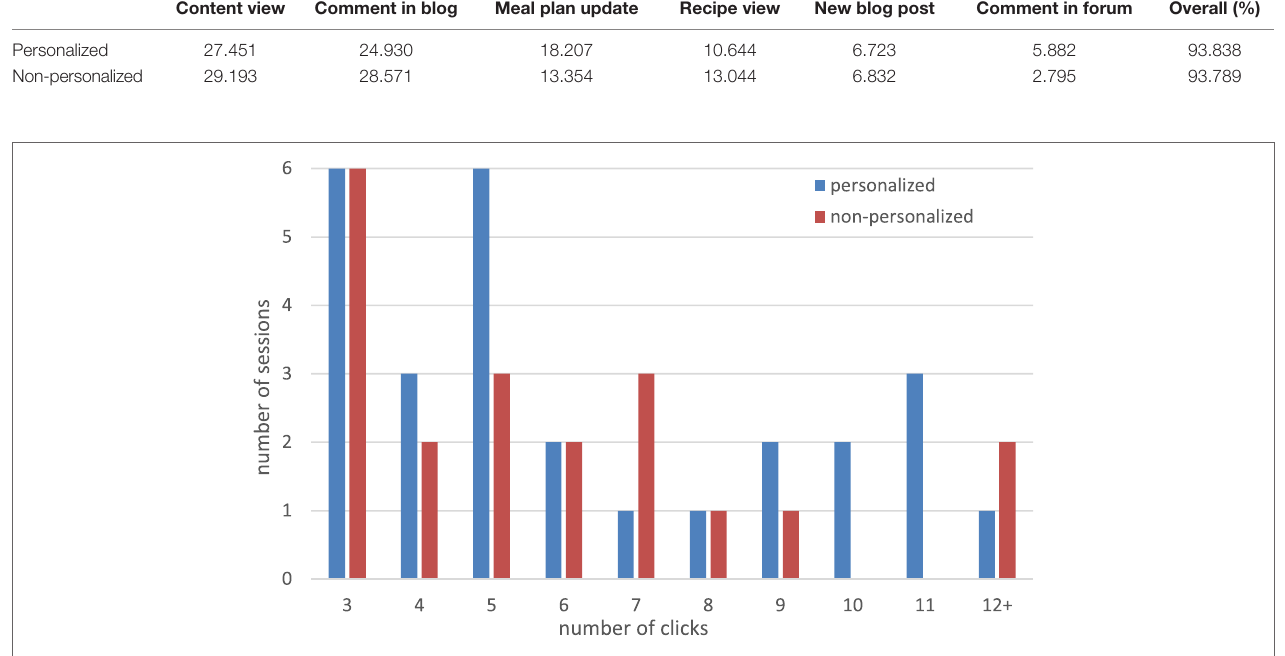
TaBle 4 | clicked activities.